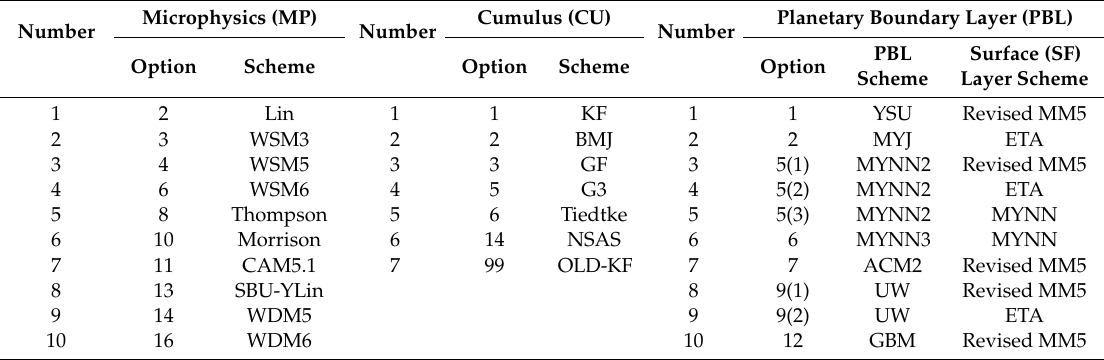
Table 2. Physics parameterization schemes selected for the combinatorial